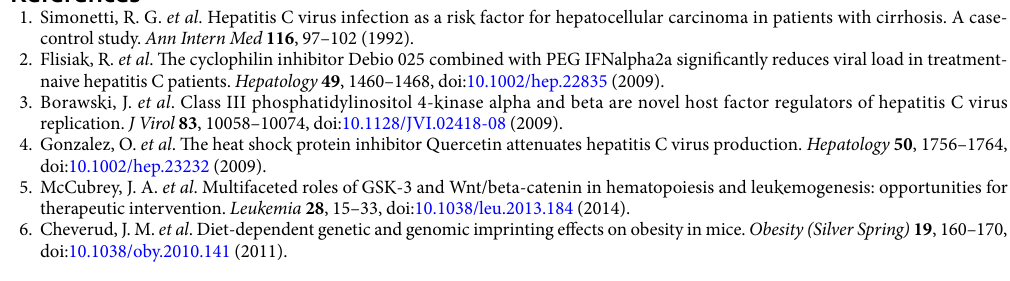
antiviral effect of GSK3 β inhibition and offer a new therapeutic modality in the treatment of HCV. It also adds new insights to our understanding of the HCV biology. A proposed model that highlights potential mechanisms of action for GSK3 β inhibitors, and the possible effect on later stages of HCV maturation and release is depicted in Fig. 8.